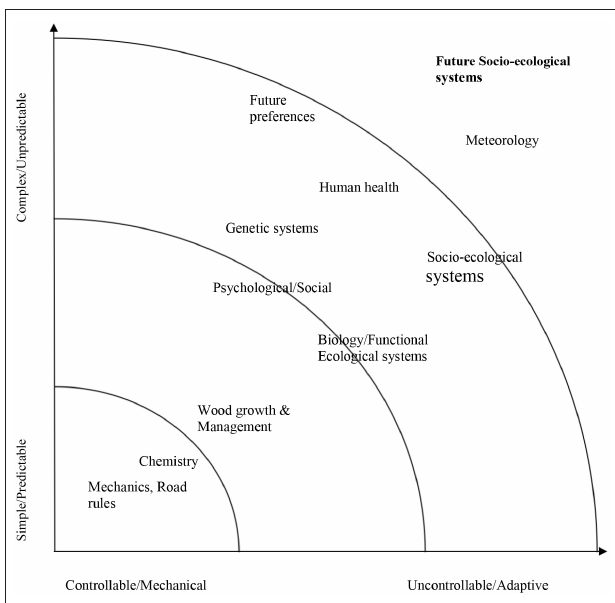
FIGURE 1 | Knowing the science-policy-operation: the limits of predictability and control.